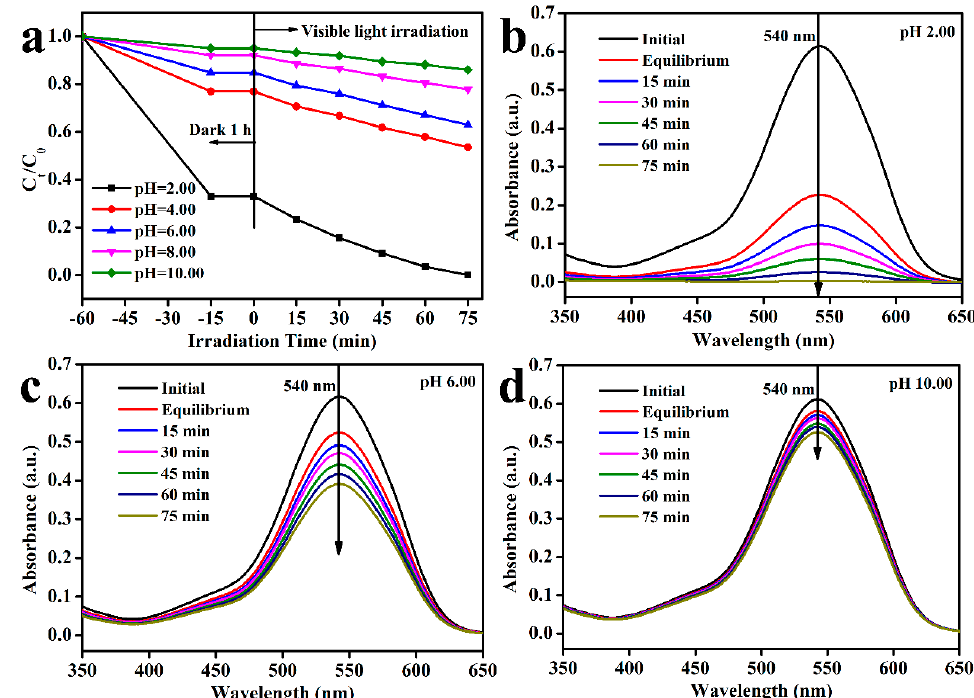
Figure 6. ( a ) Effect of pH on the catalytic activity of BBM-3. At the pH of 2.00, 6.00, and 10.00 ( b ‒ d , respectively), the UV–vis absorption spectra of Cr(VI) solution on BBM-3 sample